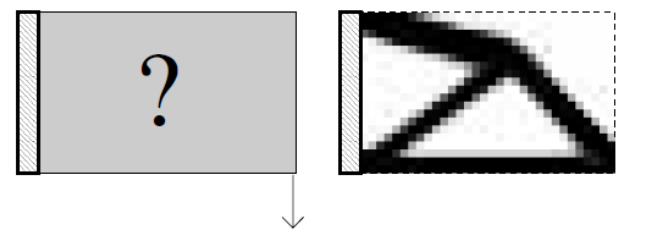
Figure 3. Structural optimization